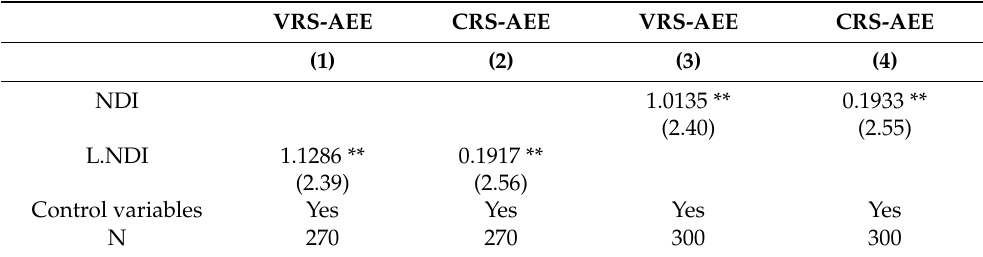
Table 9. Robustness